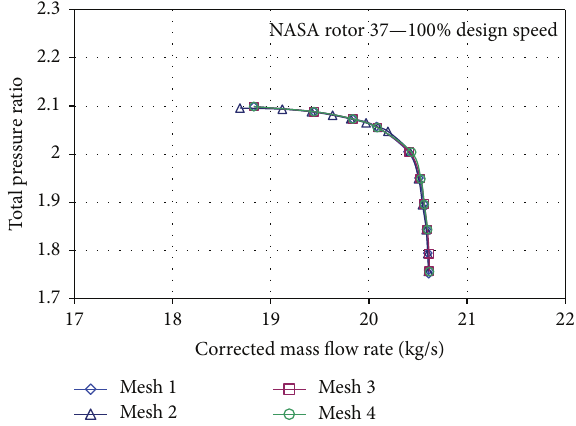
Figure6:PredictedperformancecharacteristicsofNASArotor37— grid independence